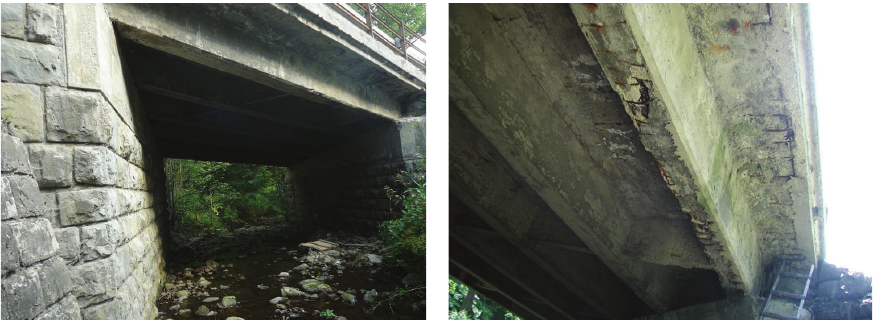
Figure 1: The diagnosed bridge structure.